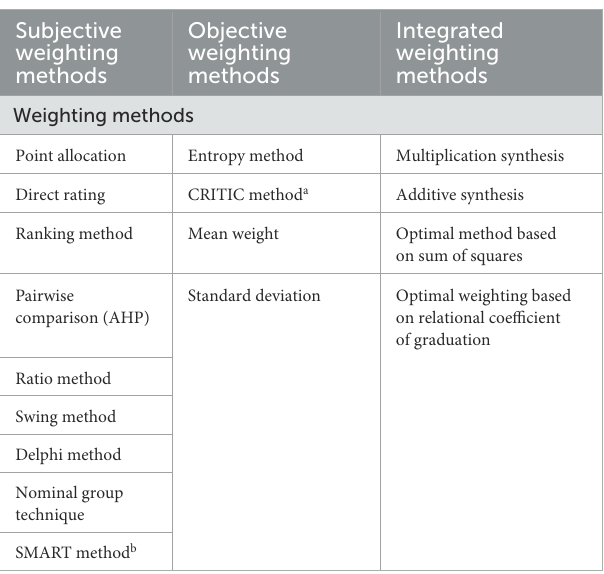
TABLE 1 Classification of weighting